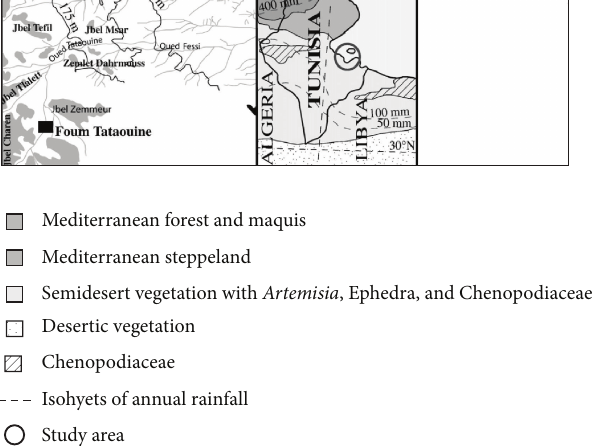
Figure 1: Location of Sebkha Mhabeul in southeast Tunisia: vegeta- tion belts and isohyets are indicated